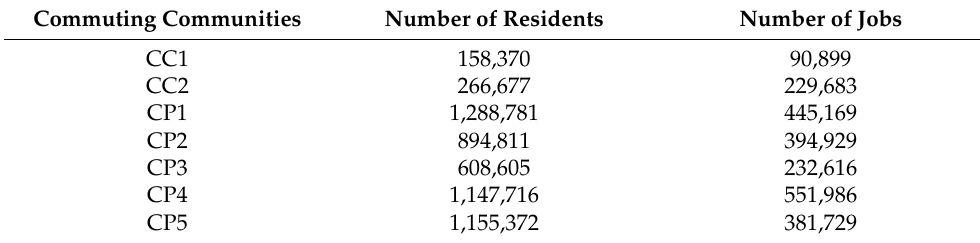
Figure 8. The commuting communities in Tianjin central area. Table 4. The number of residents and jobs of commuting communities in Tianjin central area.